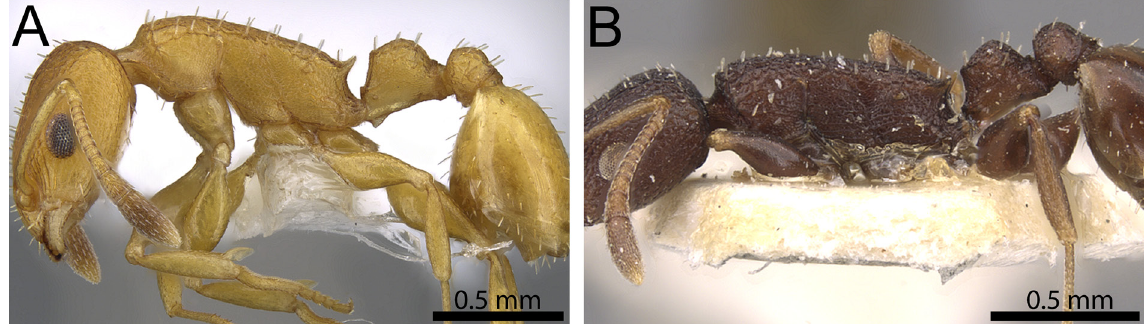
Fig. 9. Body in profile. A . Nesomyrmex angulatus (Mayr, 1862) (CASENT0922010). B . N. grisoni (Forel, 1916) (CASENT0908994).